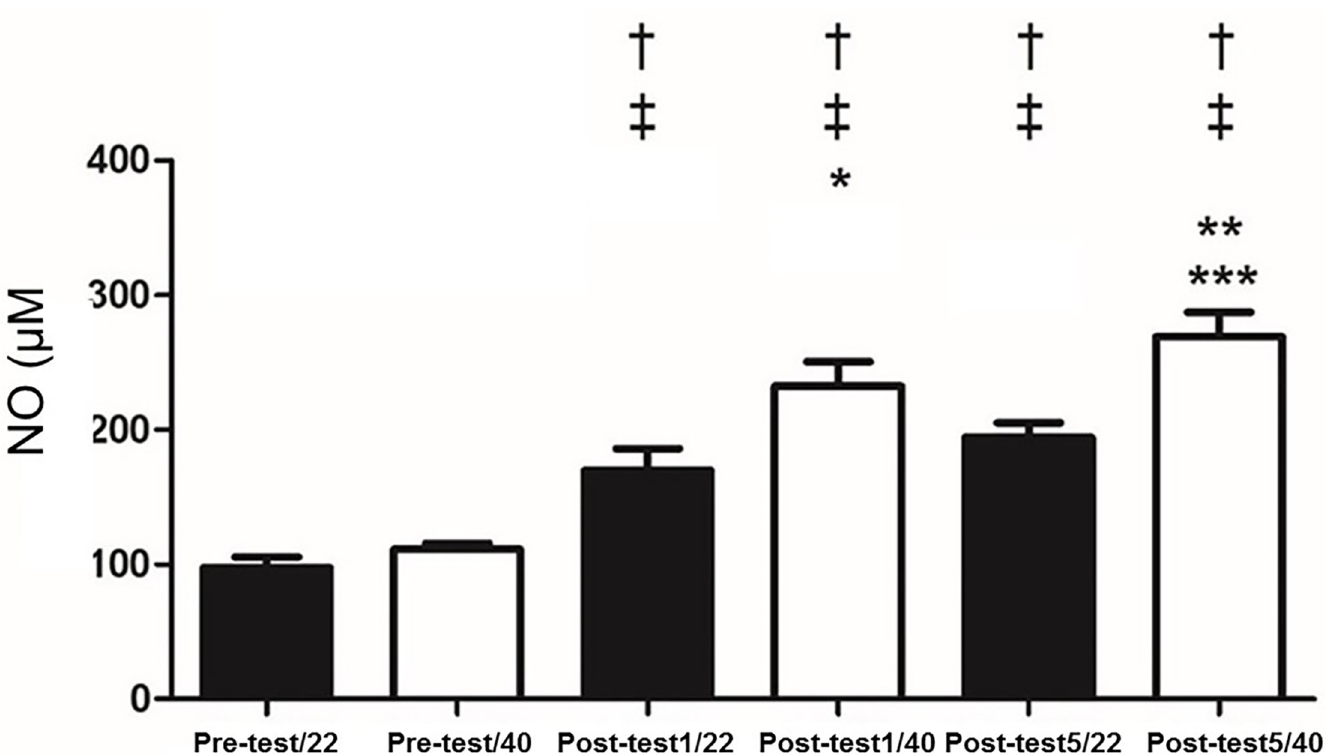
Fig 3. Salivary concentrations of nitric oxide pre-test and at one (Post-test1) and five minutes (Post-test5) after exhaustion at 22 and 40˚ C. † p < 0.05 different from Pre-test/22; ‡ p < 0.05 vs. Pre-test/40; � p < 0.05 different from Post-test1/22; �� p < 0.05 different from Post-test 1/40; ��� p < 0.05 different from Post-test 5/22.